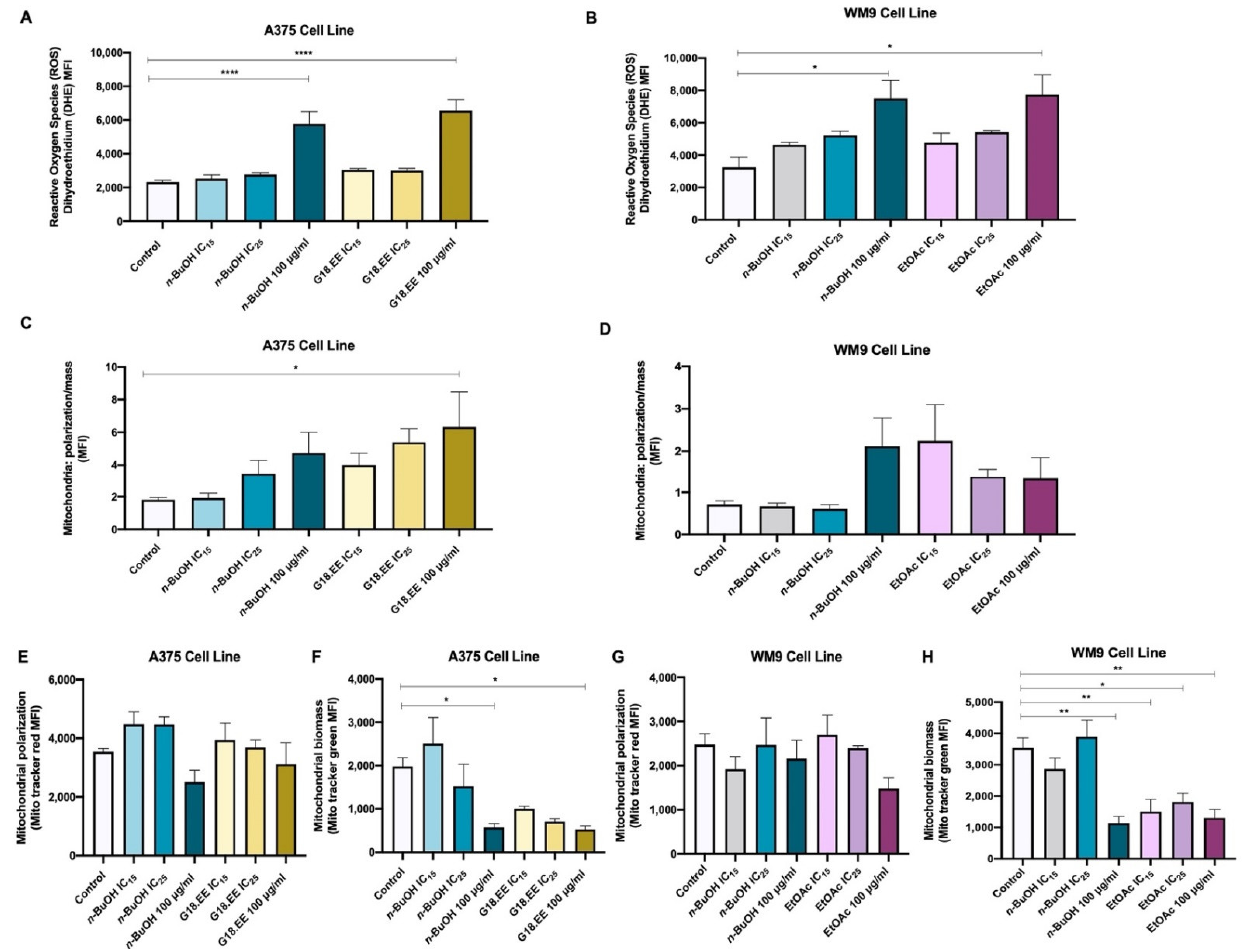
Figure 3. Treatments with G18.EE and its fractions ( n -BuOH and EtOAc) increase ROS levels and mitochondrial activity. Results were obtained after 24 h treatment with DMSO (control); n -BuOH 5 µg/mL (IC 15 ), 7 µg/mL (IC 25 ), and 100 µg/mL; and G18.EE 10 µg/mL (IC 15 ), 13 µg/mL (IC 25 ), and 100 µg/mL. ROS levels were measured in A375 ( A ) and WM9 ( B ) cell lines. Mitochondrial activity was measured in ( C ) A375 and ( D ) WM9 cell lines through the ratio of the respective ( E , G ) mitochondrial polarization by the ( F , H ) mitochondrial biomass. Results are expressed as mean ± SD. Three independent experiments were carried out in triplicate. * p < 0.05, ** p < 0.01, **** p < 0.0001. 2.3.4. G18.EE, n-BuOH, and EtOAc Treatments Induce Apoptosis in Melanoma Cell Lines